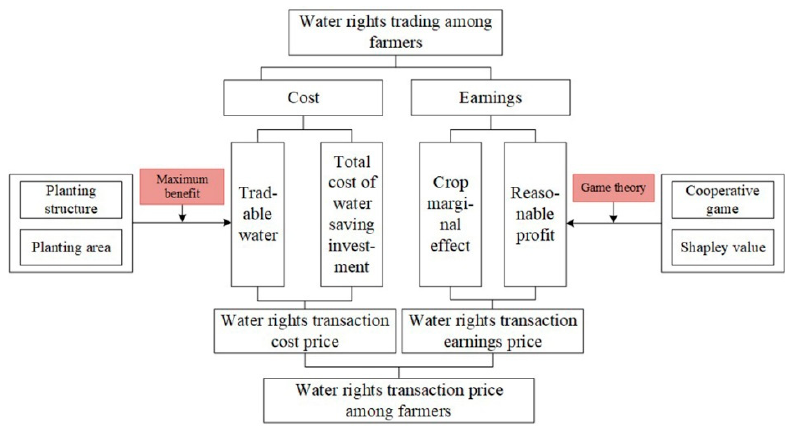
Figure 2. The price model diagram of water rights transaction among farmers.